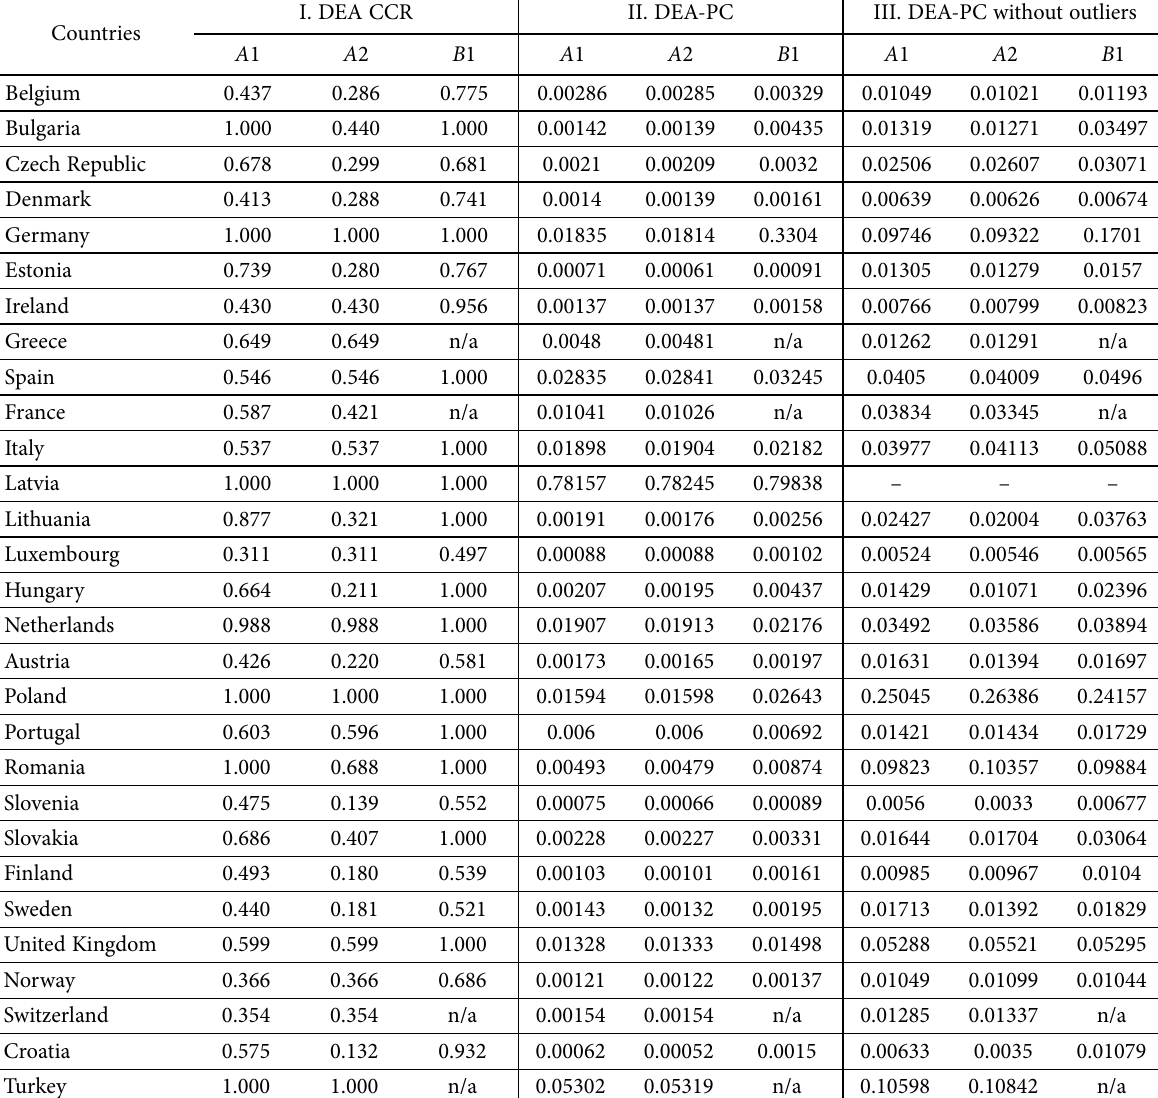
Table A. Numerical results ( source : own